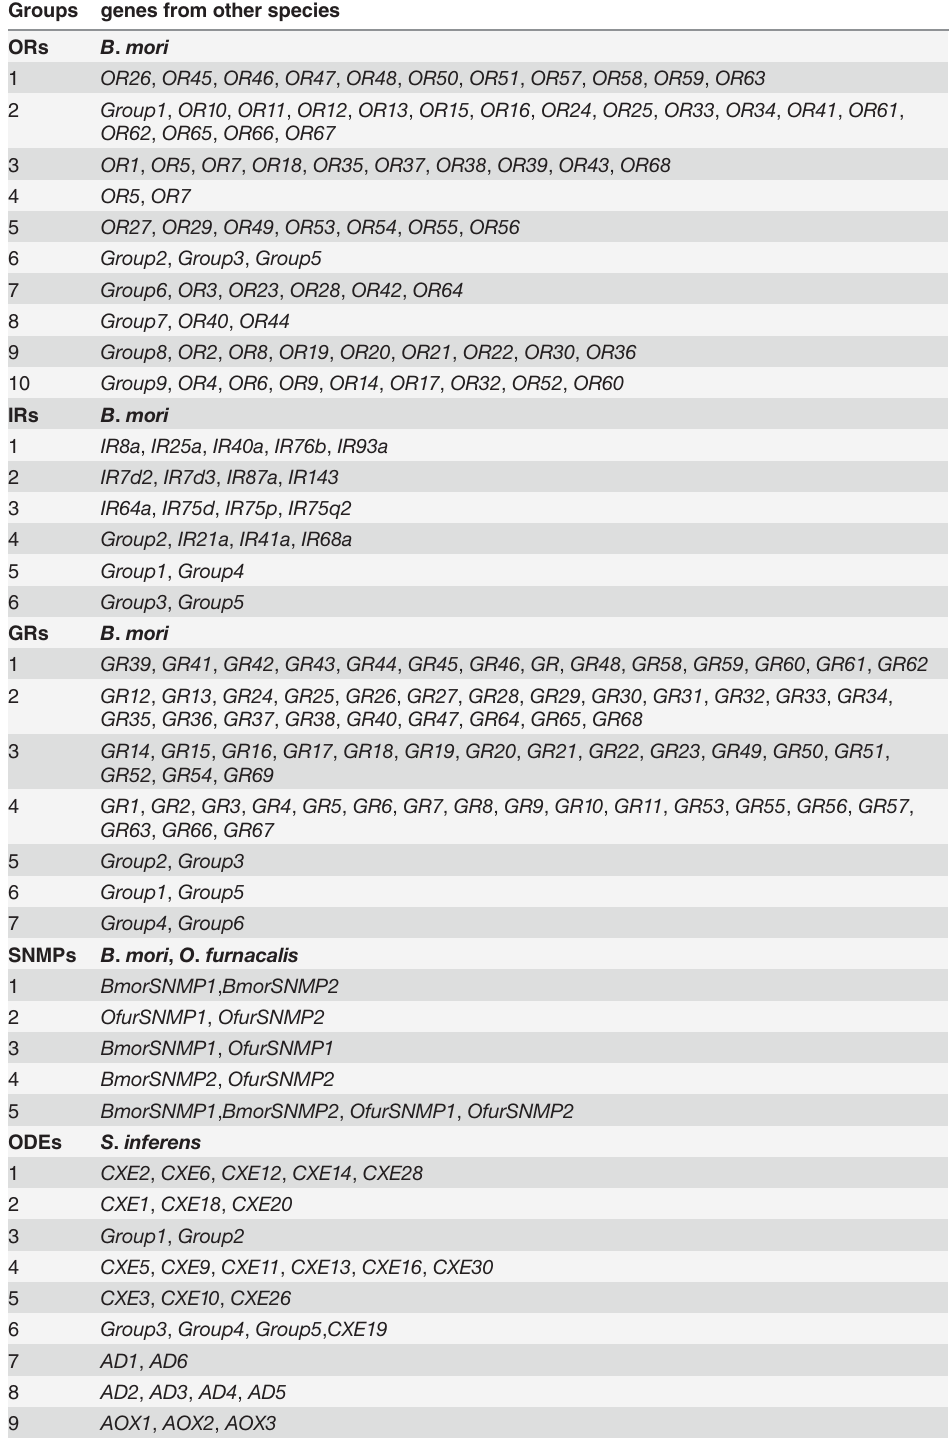
Table 1. Grouping of genes used in the query of the PSI-BLAST